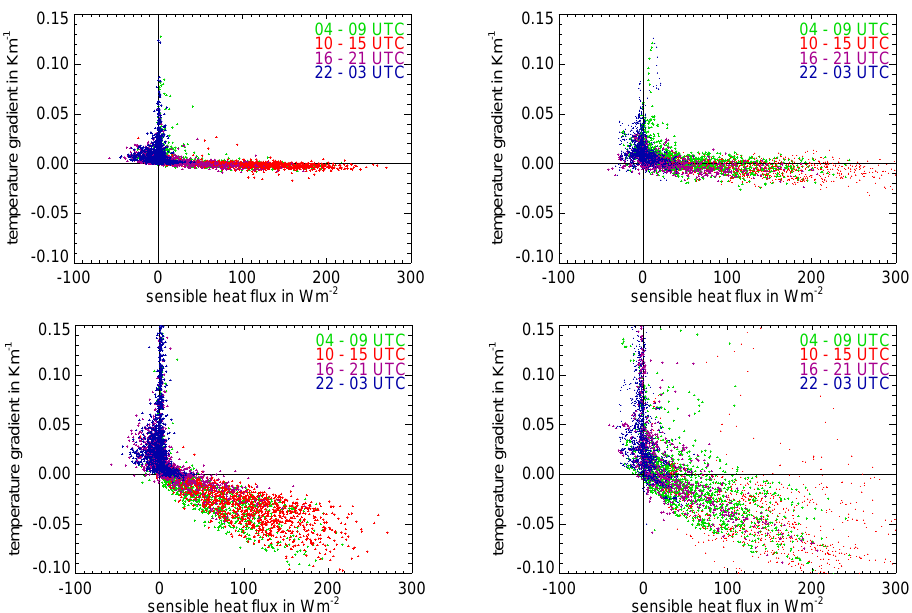
Fig. 12. Temperature gradients near the surface (lower panels) and at elevated height (upper panels) versus sensible heat flux at Billwerder (left panels) and Toulouse (right panels). Temperature gradients near the surface: 2m–10m, at elevated height: 50m–70m (Billwerder) and 40m–60m (Toulouse), sensible heat flux: 10m.